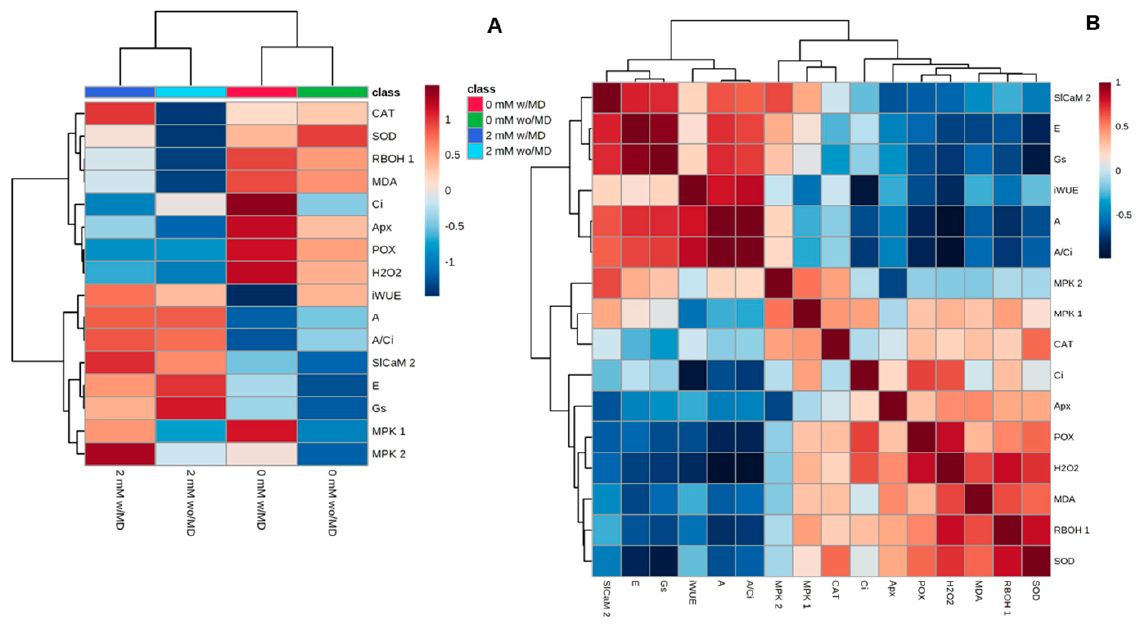
Figure 9. ( A ). Heat map and ( B ). Correlation analysis with expression of RBOH1 , MPK1 , MPK2 , SlCaM2 genes; enzymatic activity of SOD, POD, CAT and APX; hydrogen peroxide concentration; malonaldehyde; carbon assimilation; stomatal conductance; transpiration; internal carbon concentration; water use efficiency; and carboxylation efficiency of RuBisCO, in Solanum lycopersicum “cv. Micro-Tom” grown with variation in calcium concentration (mM) and with (w/MD) or without (wo/MD) mechanical damage at 0.5 h after damage. Values correspond to average ± SE ( n = 3).